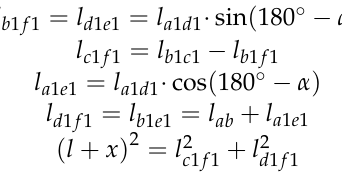
= 𝑙 = 𝑙 ∙ sin (180° − 𝛼) (cid:3029)(cid:2870)(cid:3033)(cid:2870) (cid:3031)(cid:2870)(cid:3032)(cid:2870) (cid:3028)(cid:2870)(cid:3031)(cid:2870)